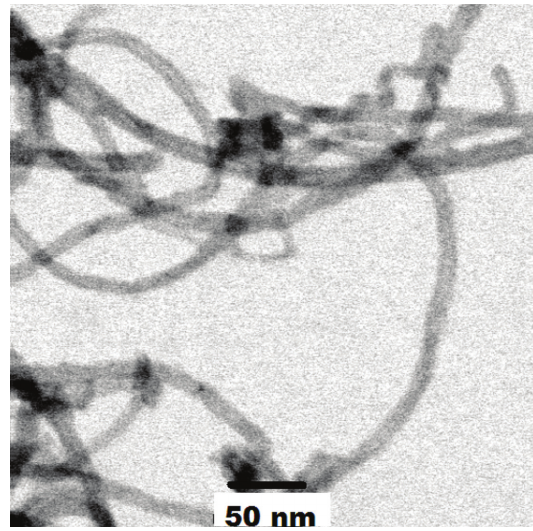
Figure 2. Bright field STEM image of MWCNT-F after acid refluxing, corresponding to the first of the two steps Ag decorating